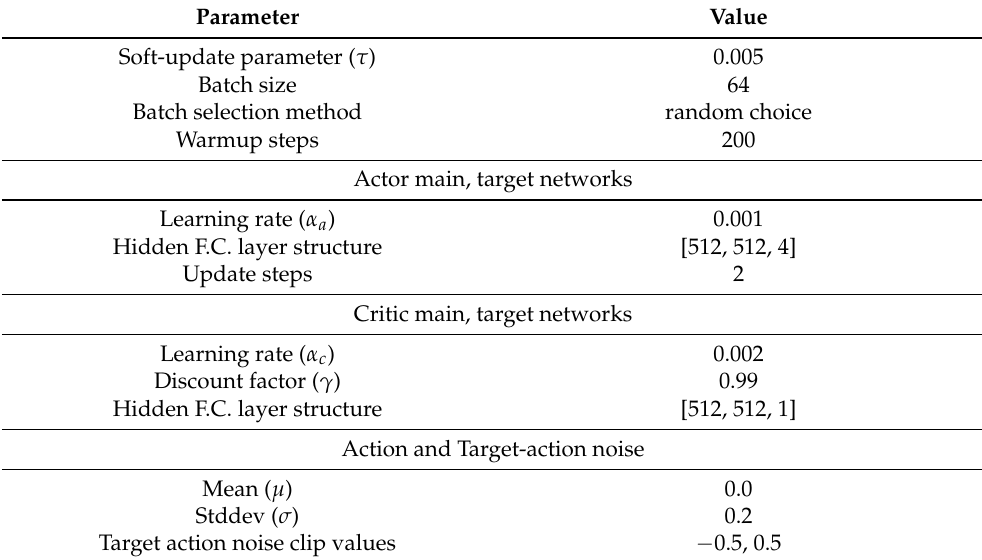
Table 1. Hyperparameters of the